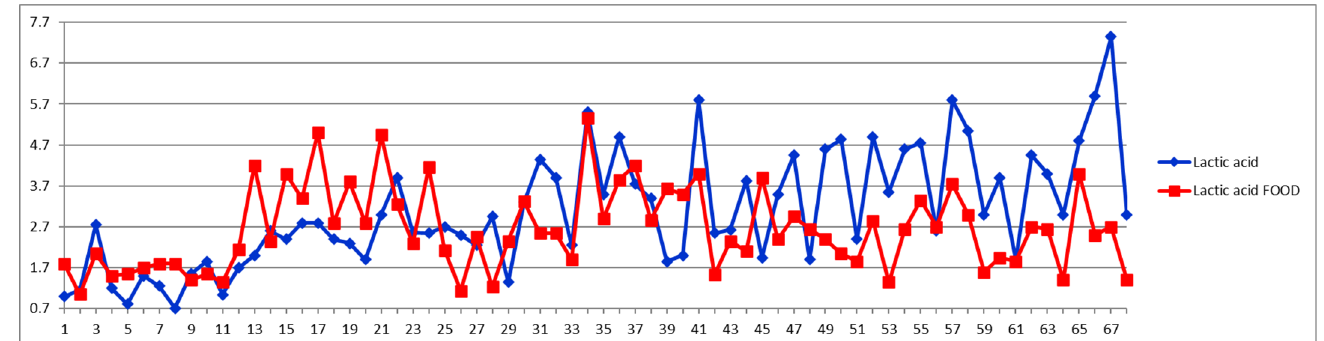
Figure 1. Lactic acid concentrations (mmol/L) in fasting (blue) and postprandial (red) status for control cases (1–29) and CVD cases (30–68).